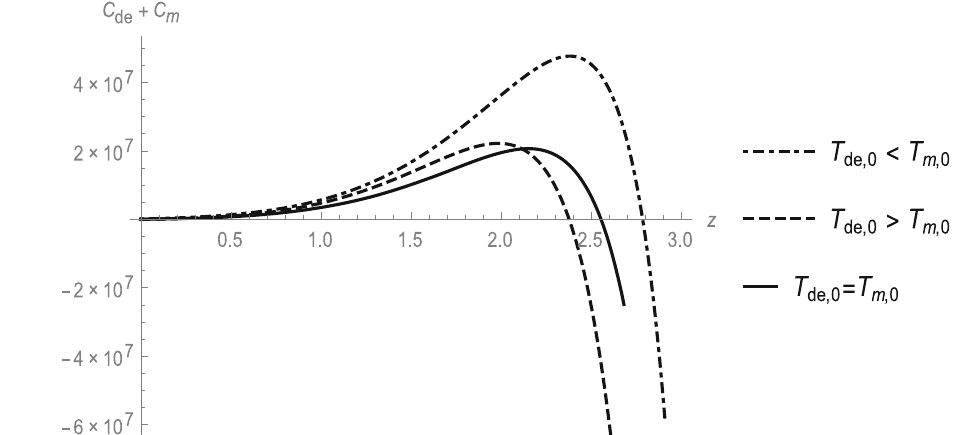
Fig. 7 Sum of heat capacities using the best fit values for the parameters of the